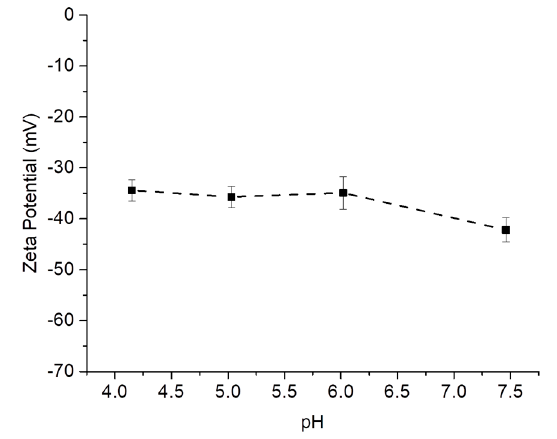
Figure 2. Zeta potential titration for Fe 3 O 4 @Si κ CRG particles.